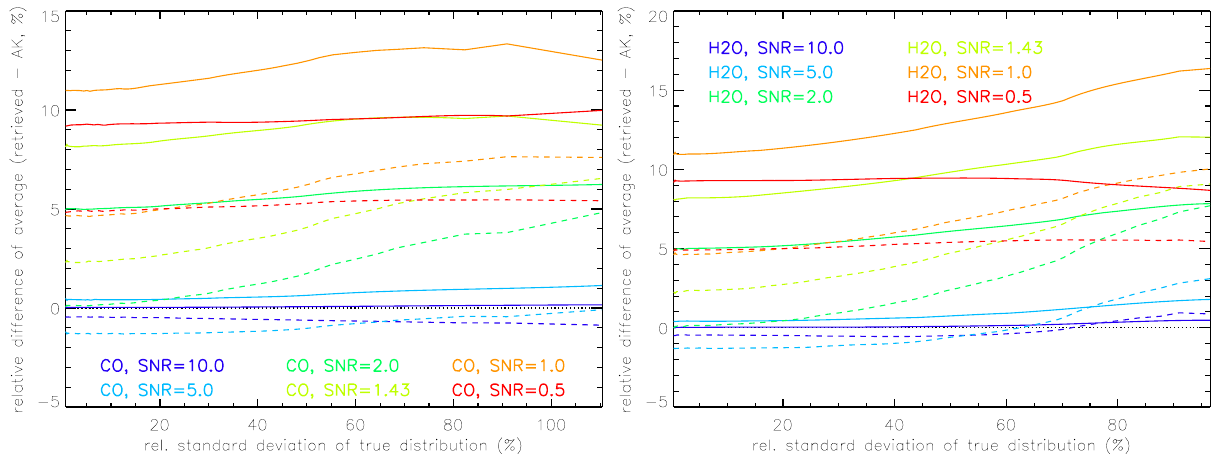
Fig. 9. Differences of retrieved and linear retrieval response (i.e. averaging kernels applied to the “true” profiles) zonal means (relative to the latter) versus standard deviation of distributions for the CO (left) and H 2 O (right). Solid: linear averages, dashed: logarithmic averages. Simulations are performed with a modified maximum a posteriori ln(vmr)-retrieval simulations using a fixed constraint corresponding to climatological variance of 100%. Results for signal to noise ratios of 10 (dark blue), 5 (light blue), 2 (dark green), 1.43 (light green), 1.0 (orange), and 0.5 (red) are